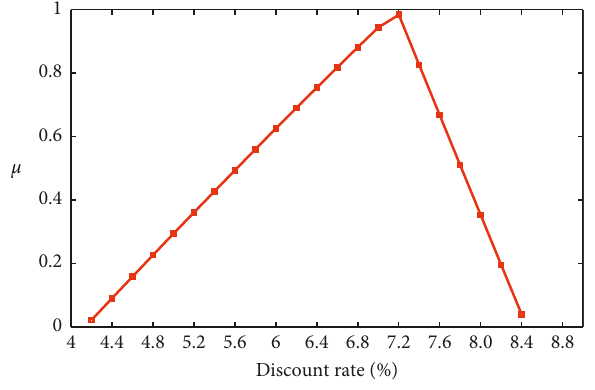
Figure 8: 2D plot of